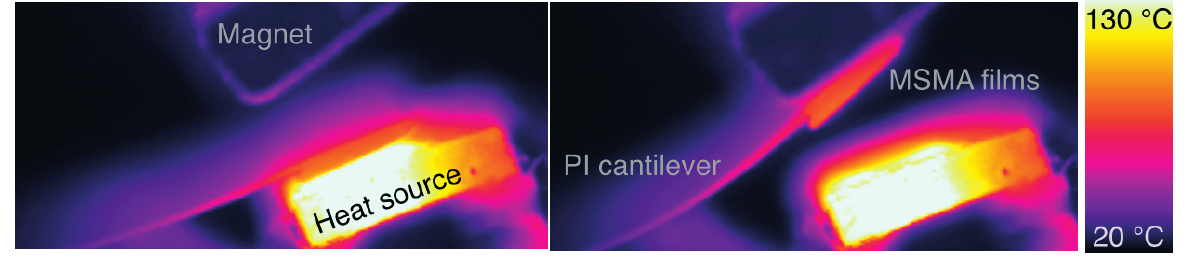
Figure 19. Time-resolved IR thermography measurement of the thermomagnetic microactuator when in contact to the heat source (left) and to the magnet (right). Adapted from